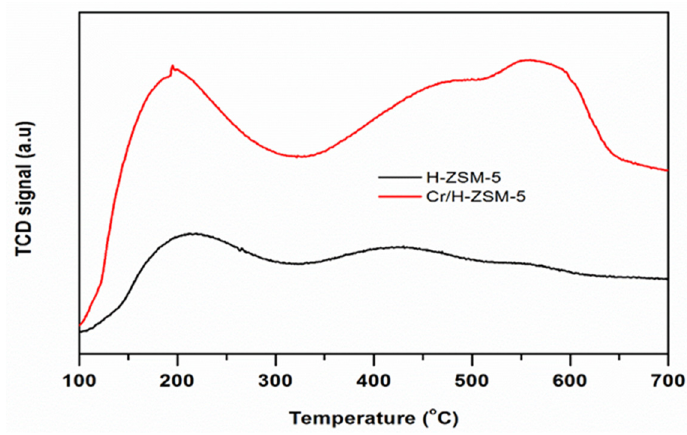
Figure 3. Ammonia-TPD analysis of H-ZSM-5 and Cr/H-ZSM-5 catalysts.